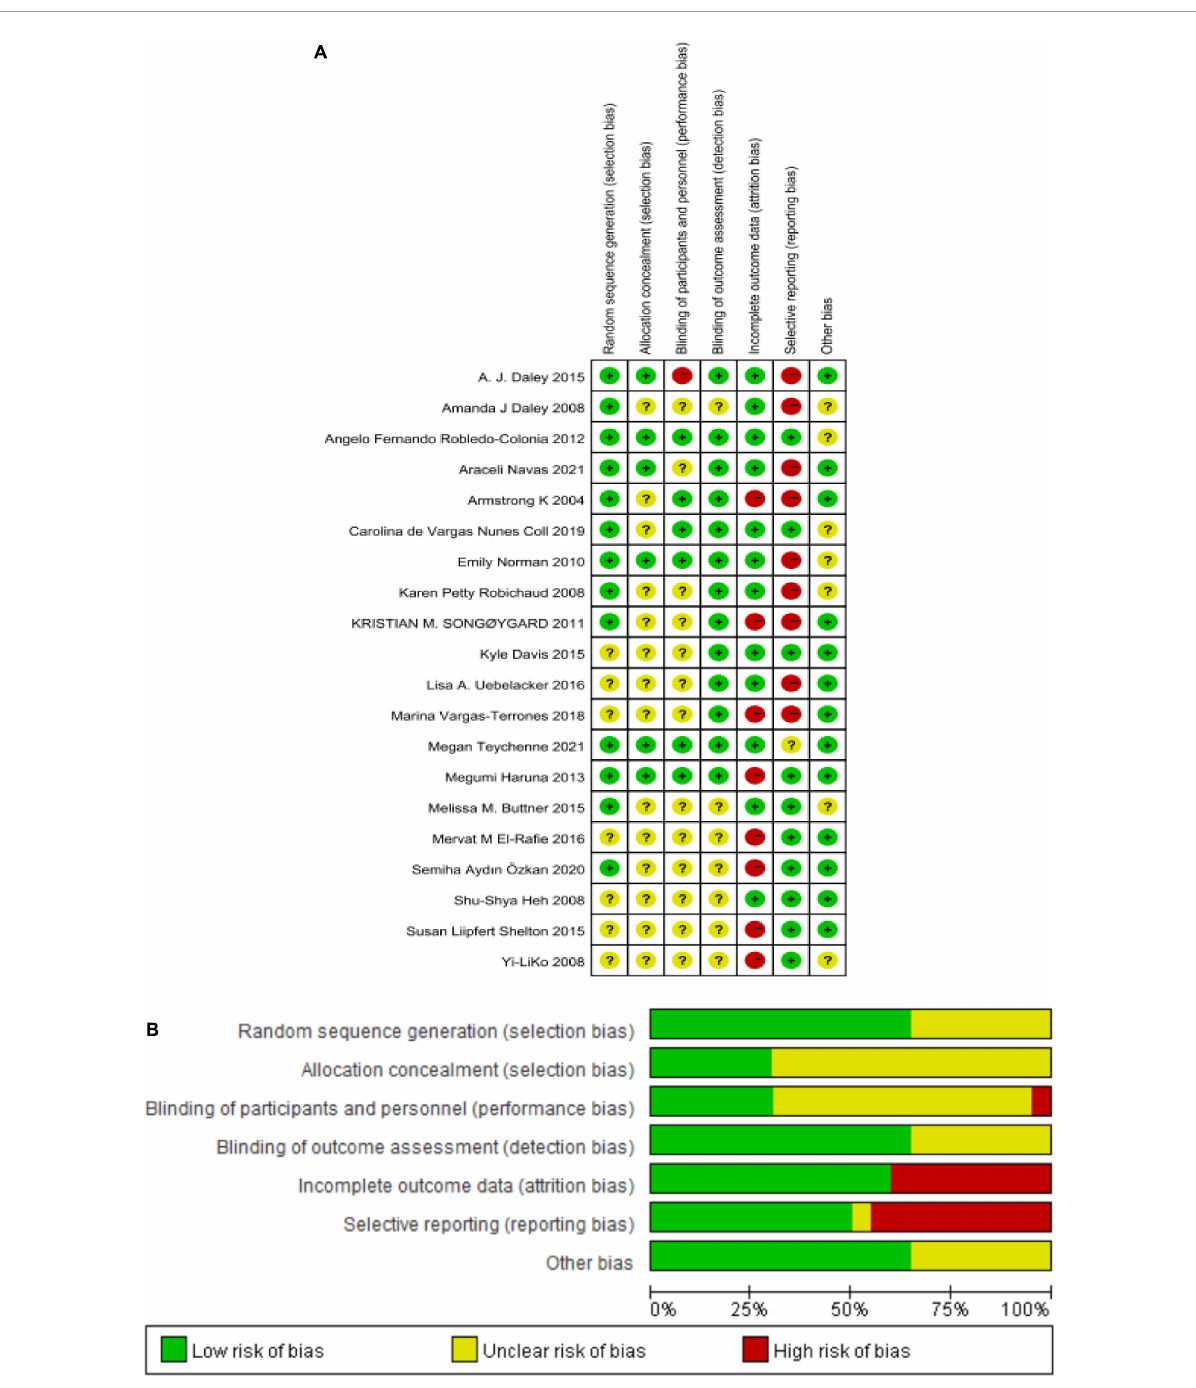
FIGURE2 (A) Reviewer’ judgments about each risk of bias item for each included study. (B) Review authors’ judgments about each risk of bias item presented as percentages across all included